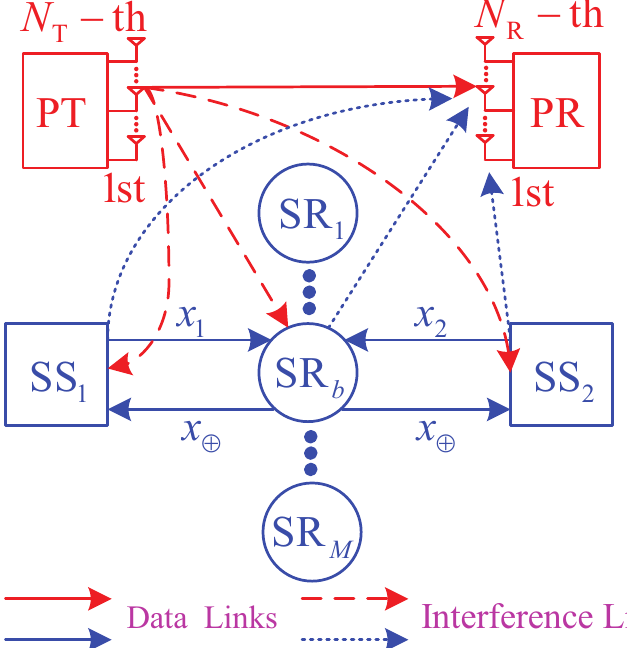
Figure 1. The DNC TWR model in the proposed underlay